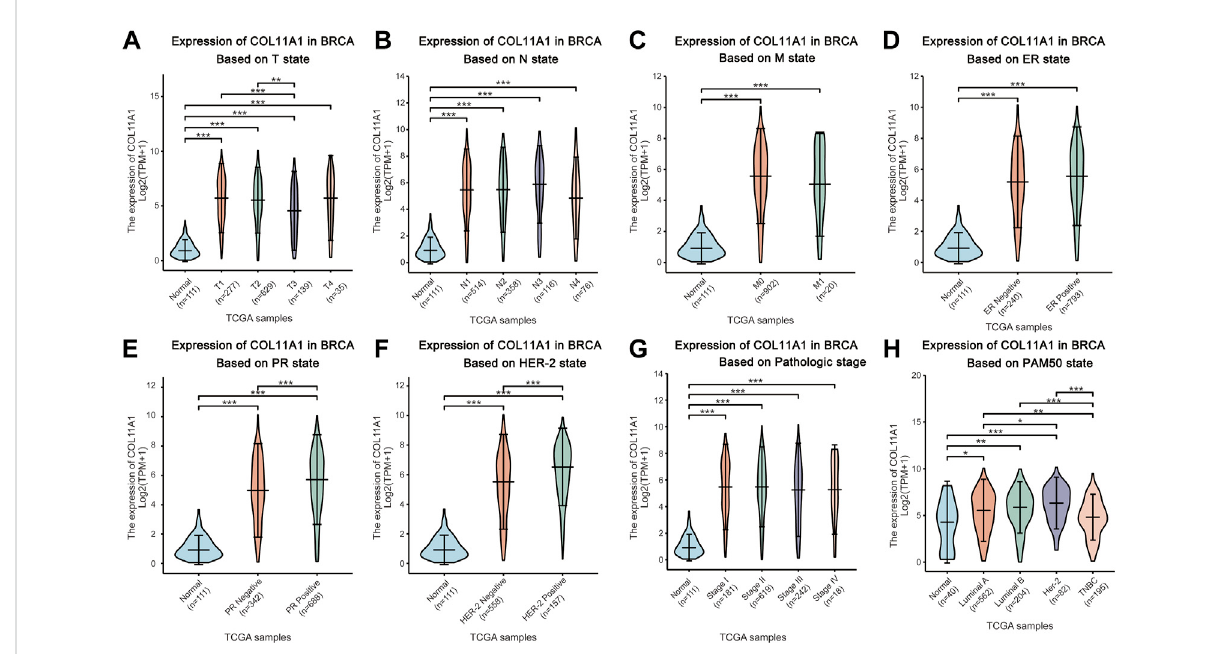
FIGURE 2 Box plots evaluating COL11A1 expression among different groups of patients based on clinical parameters using the TCGA database. Analysis is shownforTstate (A) ,Nstate (B) ,Mstate (C) ,ERstate (D) ,PRstate (E) ,Her-2state (F) ,breastcancerstage (G) andthePAM50state (H) .* p < 0.05,** p < 0.01, *** p <